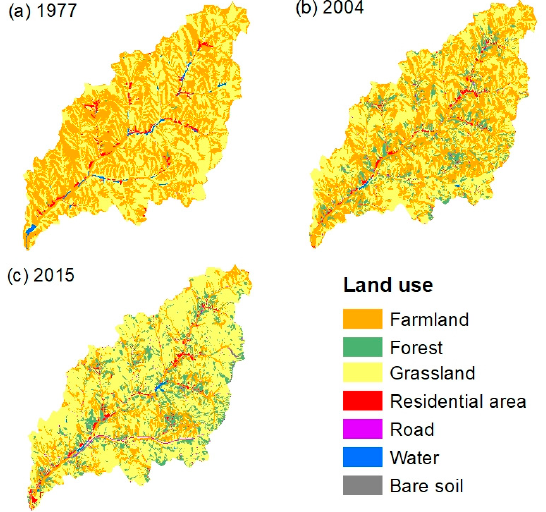
Figure 3. Area change in a different grade from 1977 to 2015 (the area of flow-in represents the area of change from 1977 to 2015, the area of flow-out refers to the opposite conversation and the area of net change was the total area change from 1977 to 2015).